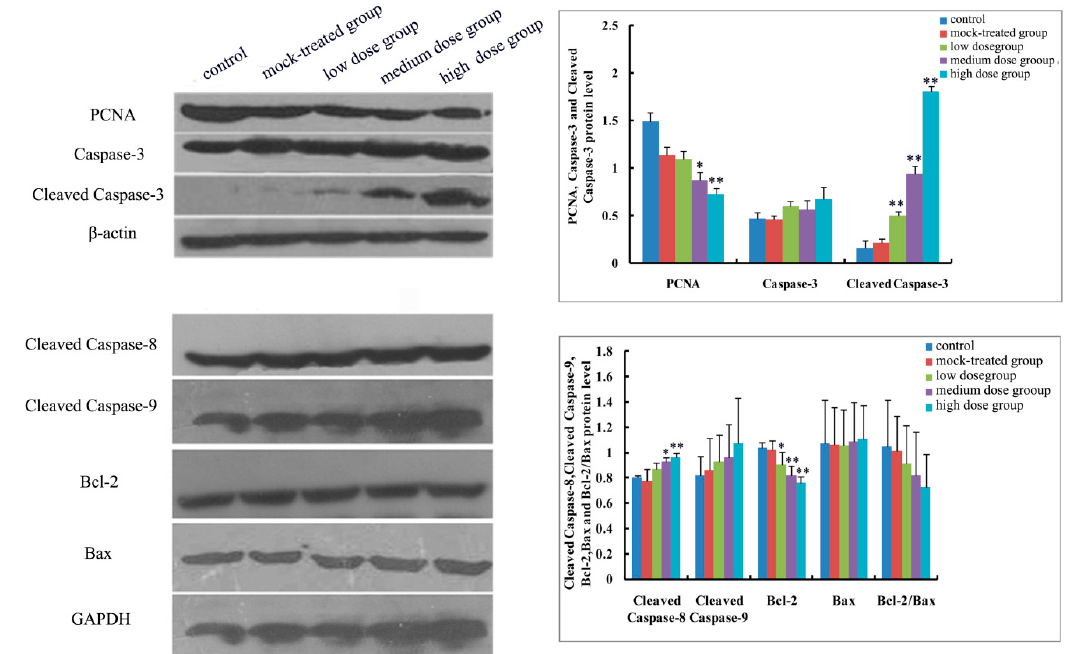
Figure 9. Expressions of apoptosis-related proteins (Caspase-3, Cleaved Caspase-3, Cleaved Caspase-8, Cleaved Caspase-9, Bcl-2, Bax and Bcl-2/Bax) and PCNA in cerebral cortex of mice offspring on postnatal day 30 after maternal exposure to PM 2.5 during pregnancy. Left: the results of western blot; Right: histogram of relative protein levels. * p < 0.05, compared with control; ** p < 0.01, compared with control.